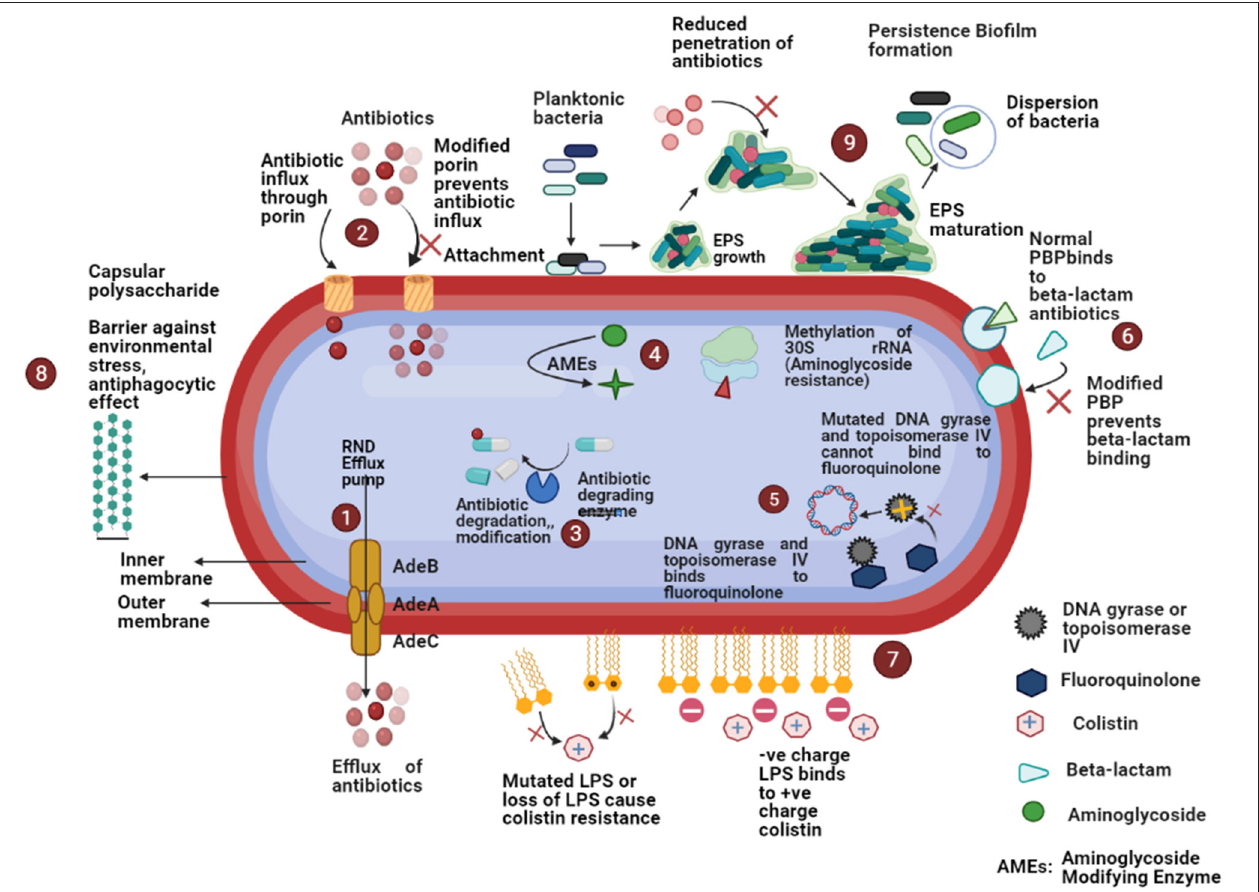
FIGURE 2 | Schematic diagram of different antimicrobial resistance mechanisms in A. baumannii : (1) increased expression of efflux pumps that expel out antibiotics from the bacterial cell; (2) reduced expression of porin or porin loss results in the decreased antibiotic entry; (3) β -lactamases cause enzymatic inactivation of antibiotics; (4) aminoglycoside modifying enzymes decrease the affinity of aminoglycoside antibiotics for ribosomal subunit or methylation of 30S rRNA decrease the binding of aminoglycosides; (5) mutations in topoisomerase IV and DNA gyrase decrease the binding of fluoroquinolones; (6) modification of penicillin-binding-proteins (PBPs) prevent the bindings of β -lactams; (7) modification of lipopolysaccharides (LPS) cause decreased binding of colistin; (8) presence of capsular polysaccharide acts as a barrier against environmental stress, anti-phagocytic effect, etc.; (9) ability to form biofilm cause high antimicrobial